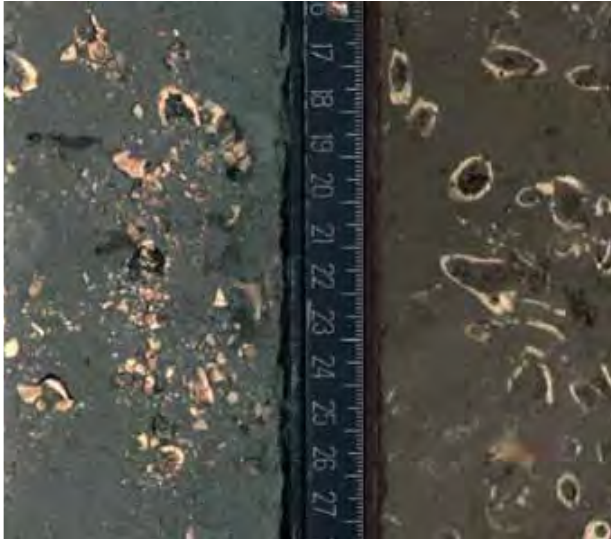
Figure 5. Comparison of cores split with traditional (left) versus freezing and sawing (right)